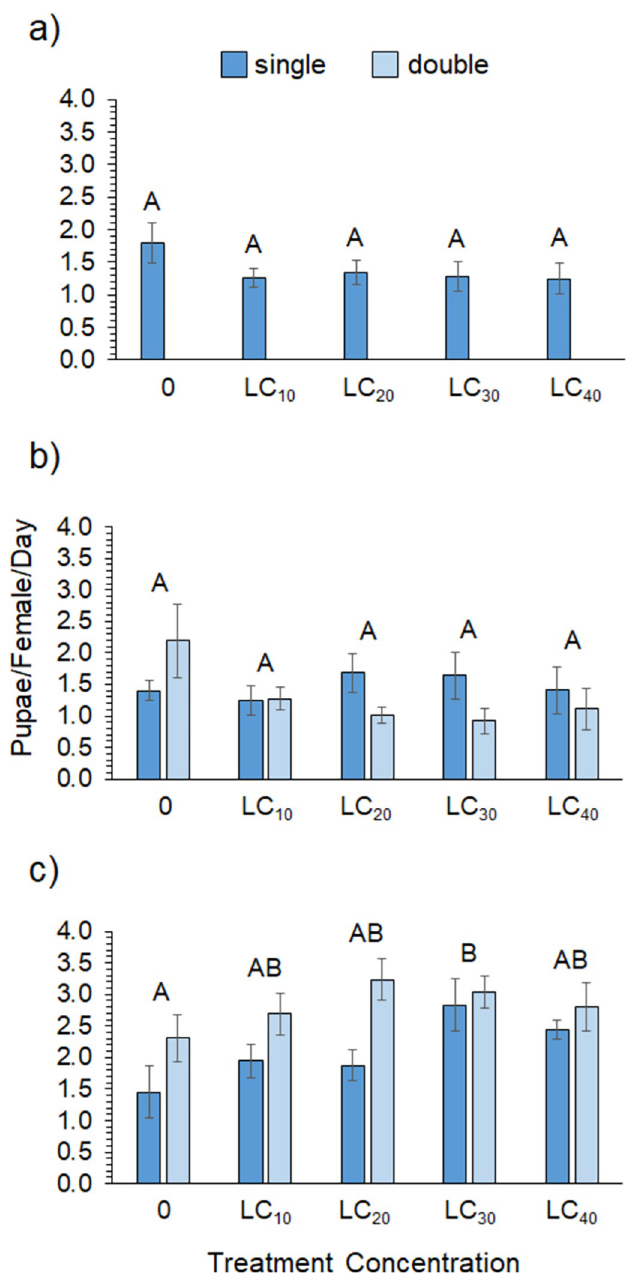
Fig 2. Survivorship. Average survivorship for male and female flies across sub-lethal concentrations of (a) zeta- cypermethrin, (b) single-exposure and (c) double-exposure to spinetoram, (d) single-exposure and (d) double- exposure to pyrethrin (N = 10). Different letters indicate significant post-hoc differences between treatments or sex where significant main effects or interactions were found (S1 and S2 Tables; Tukey’s Test, P �